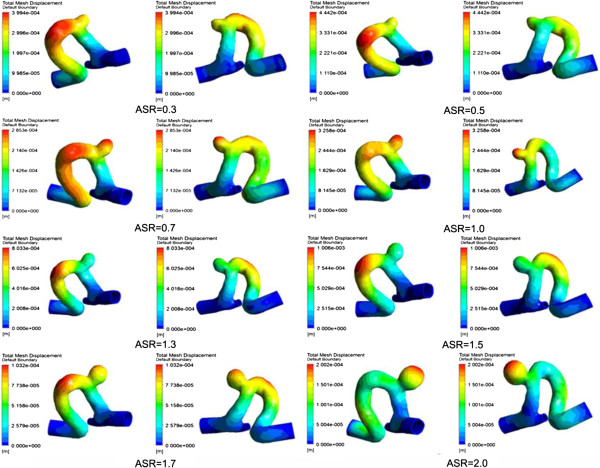
The wall displacements of the vessel within all the aneurysm models. The large displacements occur at the apexes of the scaled aneurysm models which are shown obviously especially when ASR = 0.7, 1.0, 1.5.